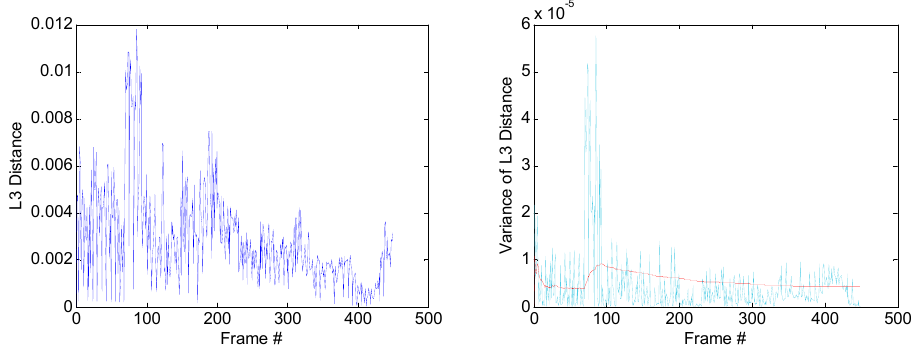
Figure 13. Distance curve with different normalization. The left figures are distance curves between selected region and target model in the model-matching process. The variance information of the distance curve are shown in the right figures. The red plots represent the statistical variance information of historical frames, and light-blue plots represent the distance bias of the current frame.